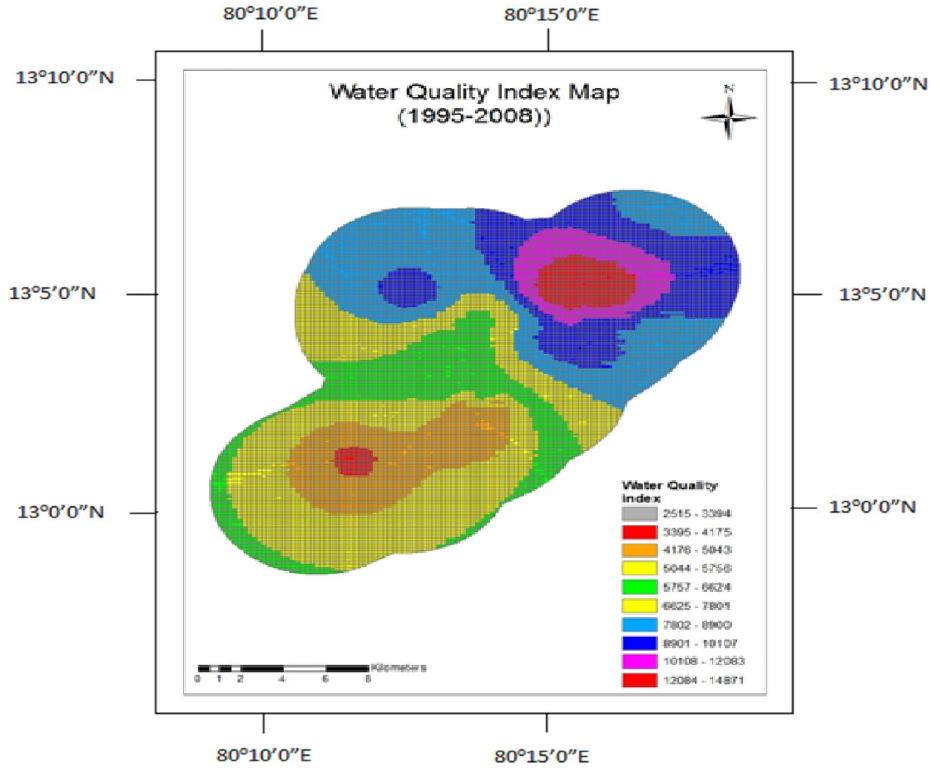
Figure 7. Water quality index map for 1995–2008.